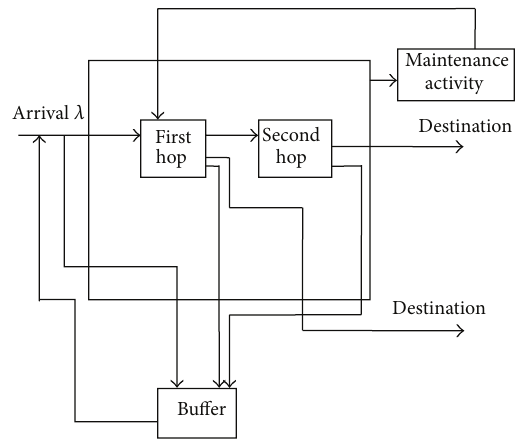
Figure 3: Block diagram of buffering and retransmission